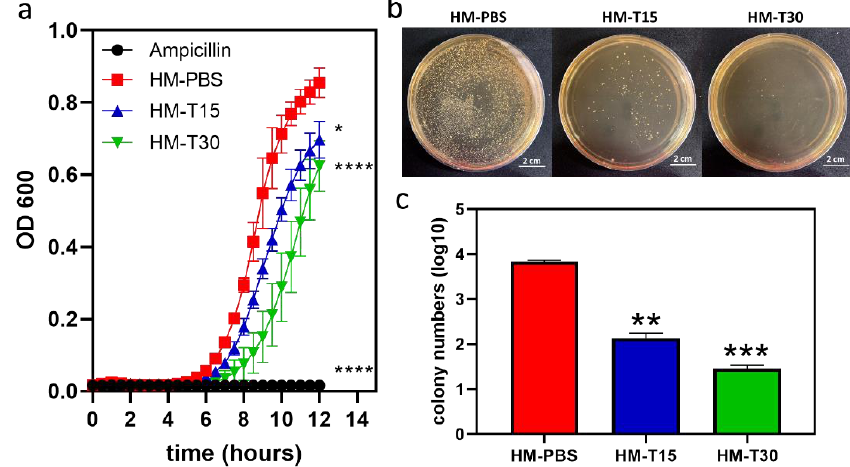
Figure 4. S. aureus growth curves for 12 h were analyzed using the kinetic microplate method ( n = 3). ( a ) Bacterial colonies of different samples cultivated on agar plates for 24 h ( n = 3). ( b ) Colony numbers. ( c ) One-way ANOVA, * p < 0.05, ** p < 0.01, *** p < 0.001, and **** p <0.0001 compared with the HM group.